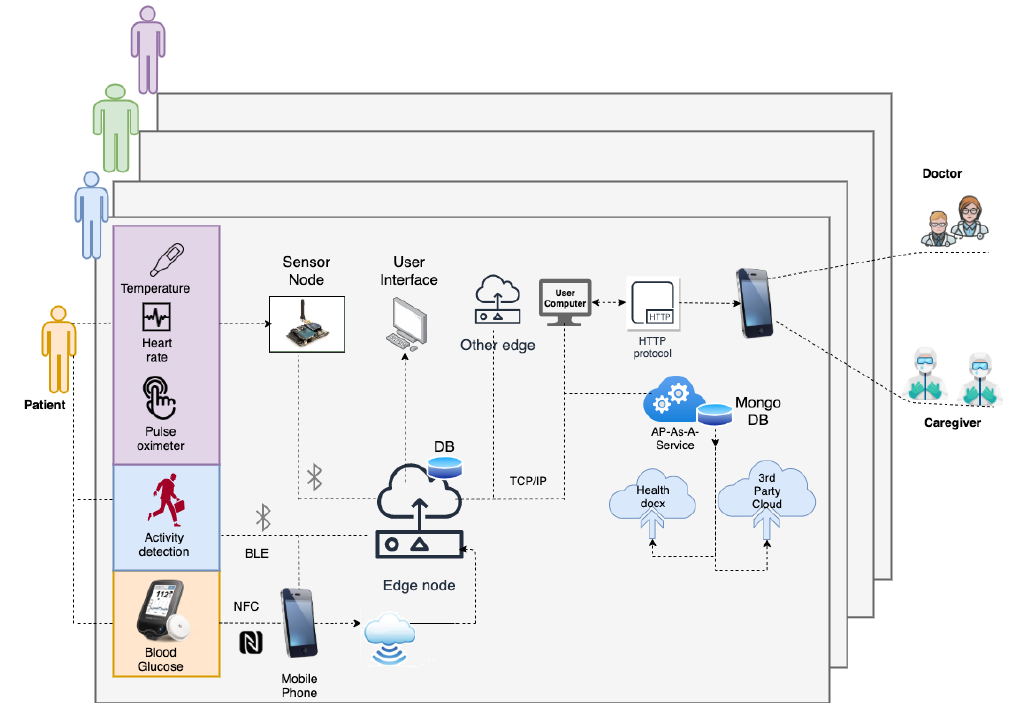
Figure 3. IoMT Architecture—Data transfer using IoT sensor devices from patients’ (left), mounted devices to edge nodes (center) to the HDT architecture and finally to medical personnel and caretakers using a mobile